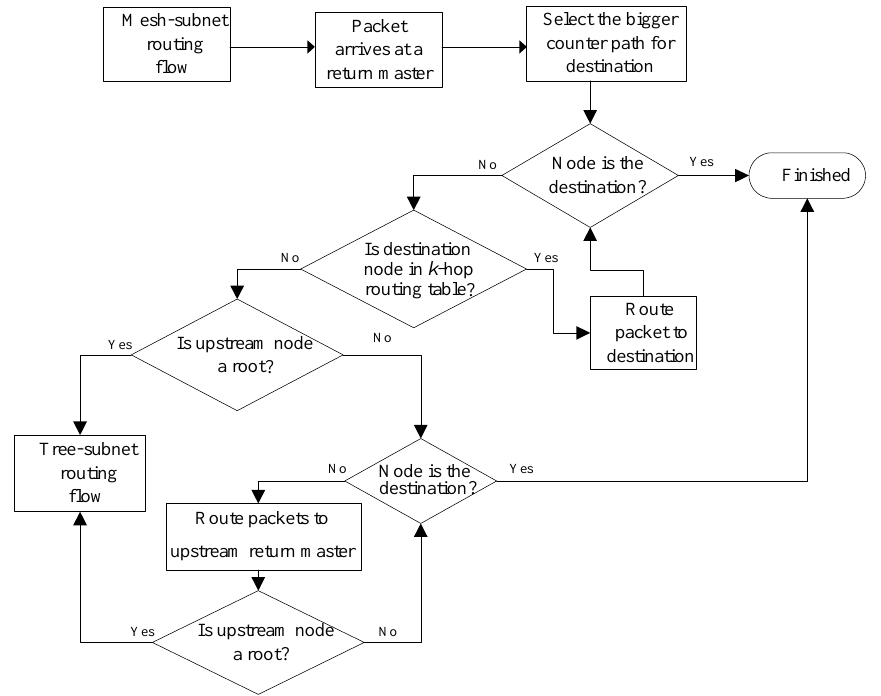
Figure 7. Flow diagram of two disjoint paths routing in a mesh-subnet.